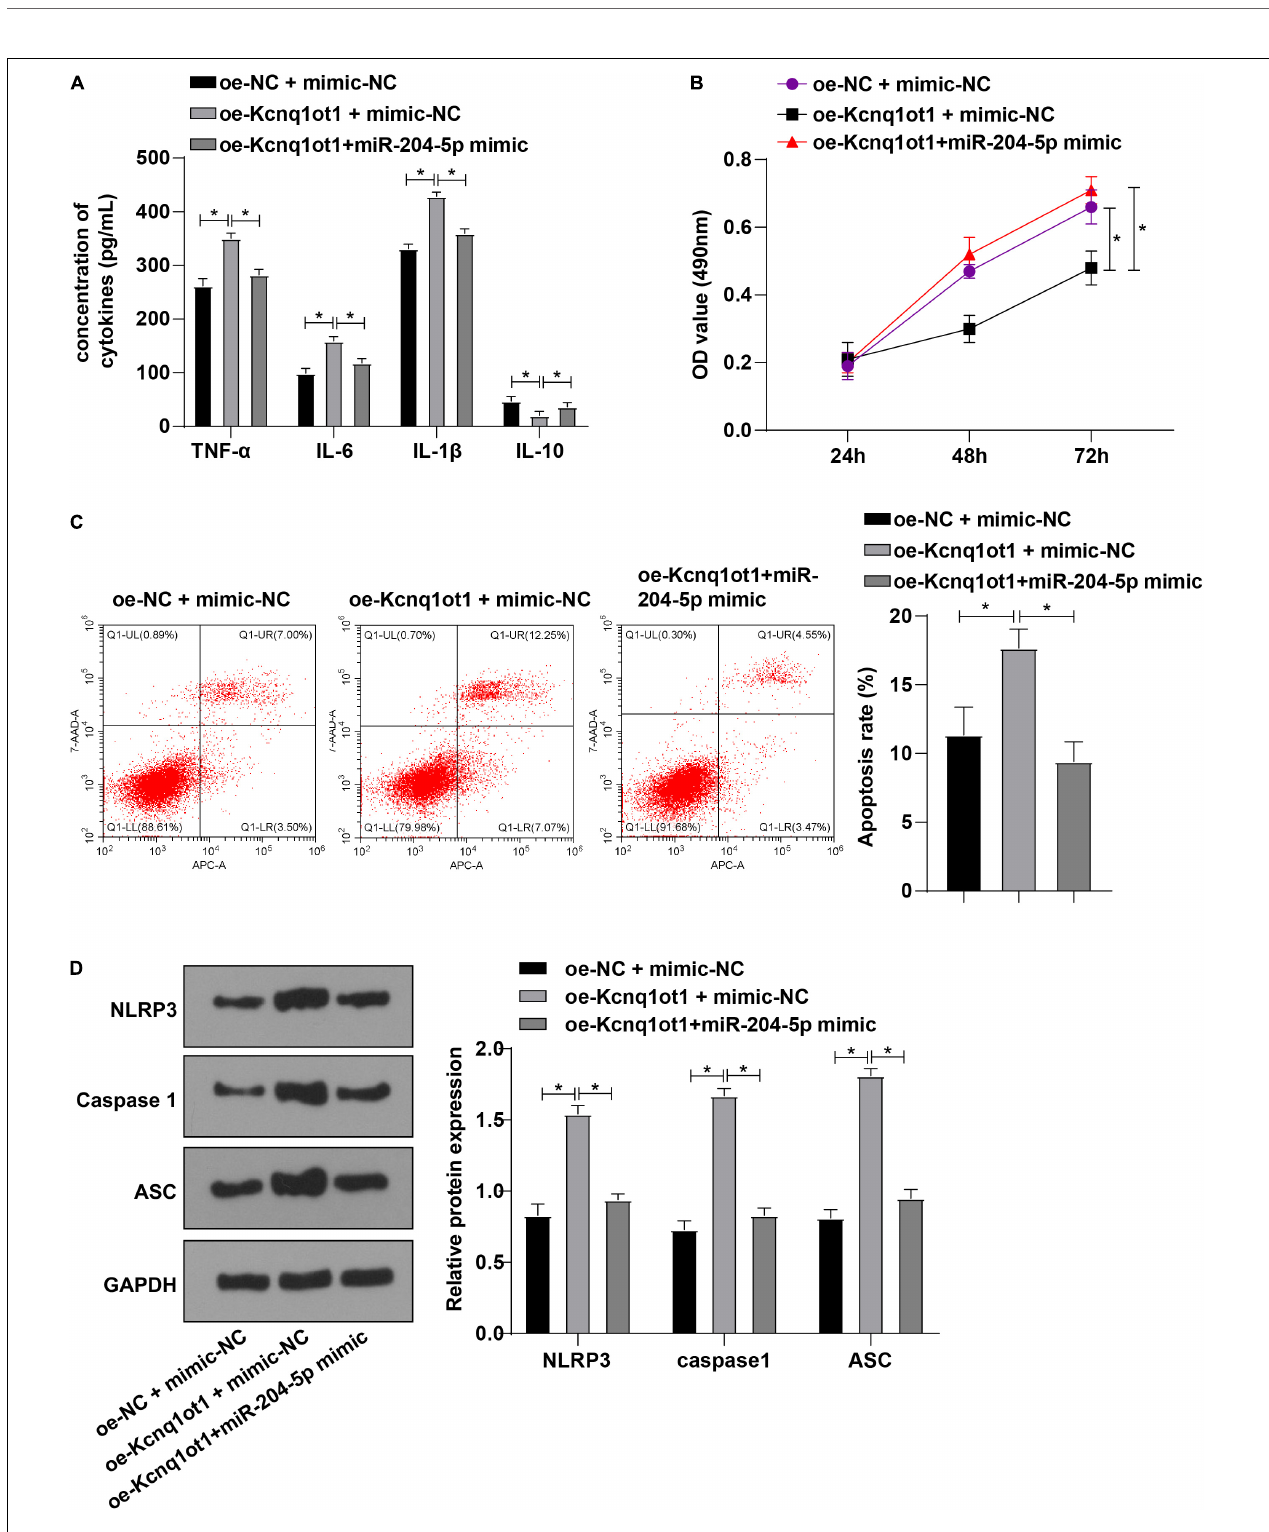
FIGURE 4 | miR-204-5p overexpression averted the promotion of Kcnq1ot1 on inflammation in the H/R model of HK-2 cells in vitro . (A) Levels of TNF- α , IL-6, IL-1 β , and IL-10 in the supernatants were detected by ELISA; (B) cell viability was detected by CCK-8 assay; (C) cell apoptosis was detected by flow cytometry; (D) levels of NLRP3 inflammasome related factors were detected by Western blot. All data in this figure were measurement data and presented as M ± SD . Comparison among multiple groups was analyzed using the one-way ANOVA and Turkey’s post hoc test while comparison among groups at different time points was analyzed using the repeated measures ANOVA, followed by Bonferroni’s post hoc test. * P < 0.05. The experiment was repeated three times.